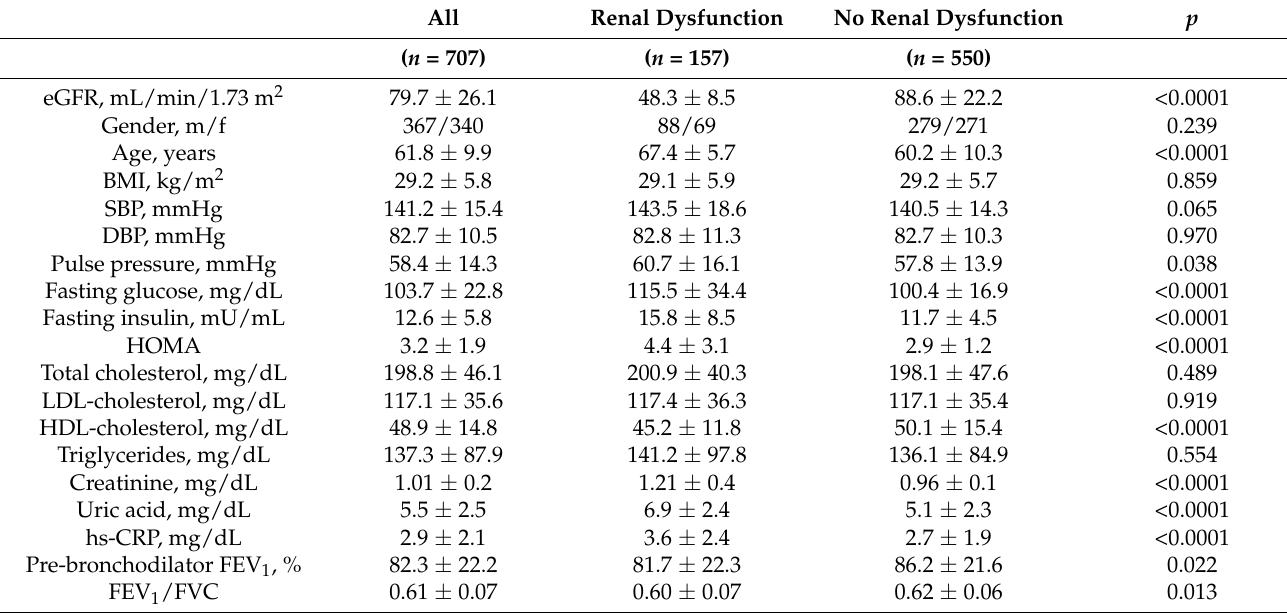
Table 1. Anthropometric, hemodynamic, and biohumoral characteristics, stratified according to the presence or absence of renal dysfunction (eGFR < 60 mL/min/1.73 m 2 ) at baseline.